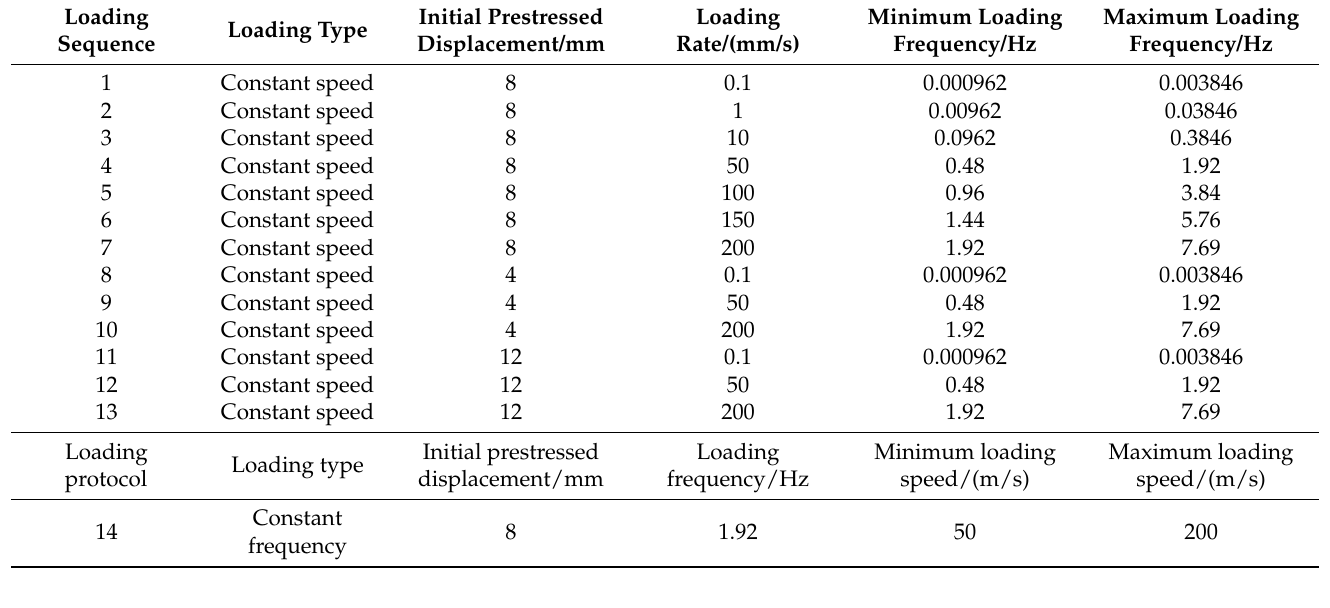
Table 2. Loading rates and frequency for hysteretic test.